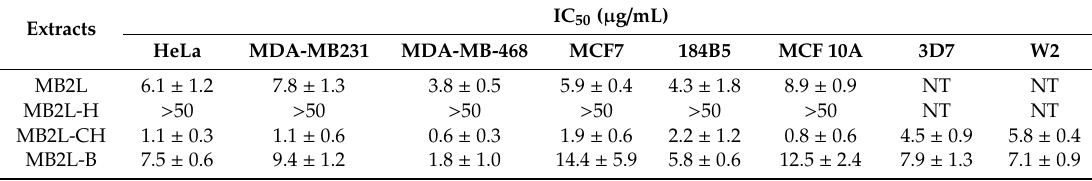
Figure 1. Compounds isolated from Stephania dielsiana Y.C. Wu. Table 1. Anti-proliferative activity of S. dielsiana Y.C. Wu extracts against cancer, non-cancer, and parasite cells.